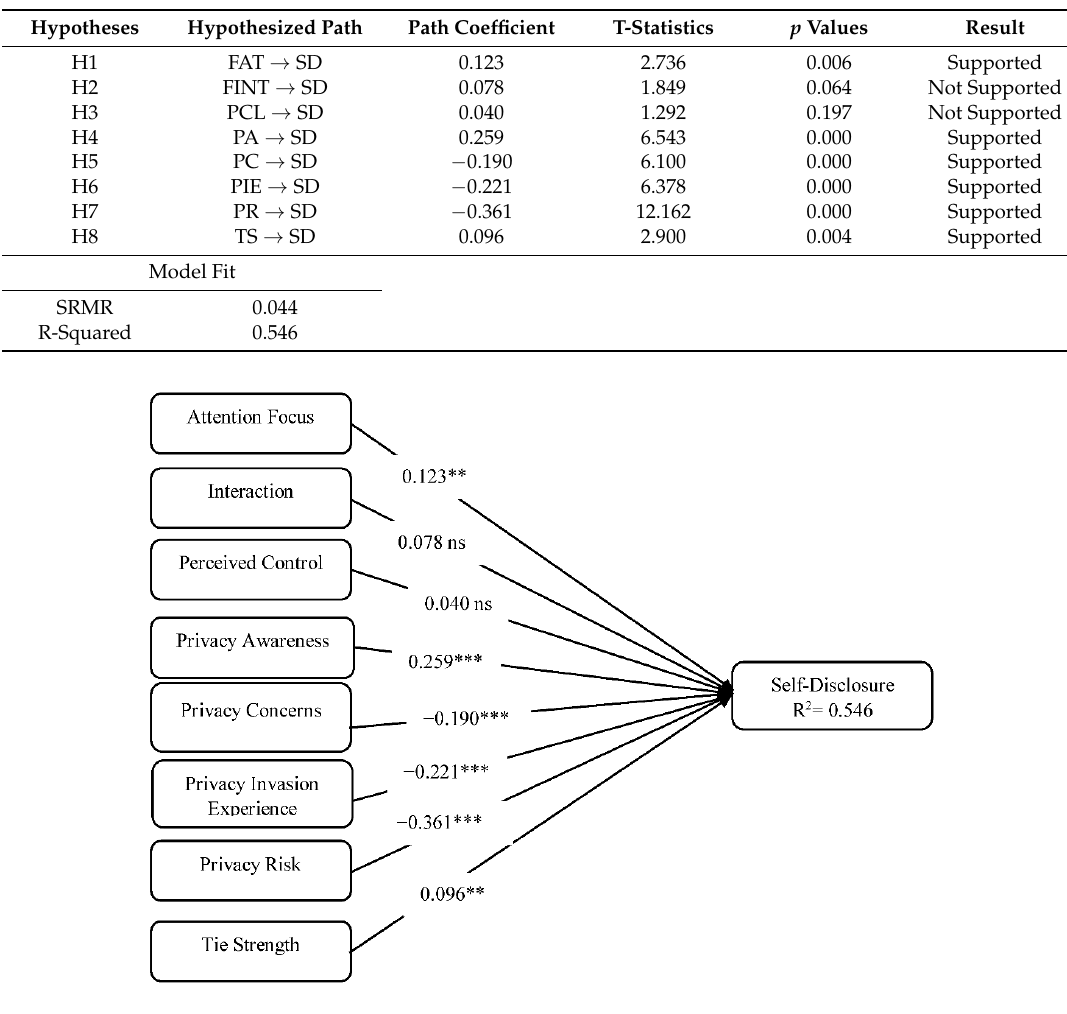
Figure 1. Structural model. *** p < 0.001 ** p < 0.01 ns—not significant.